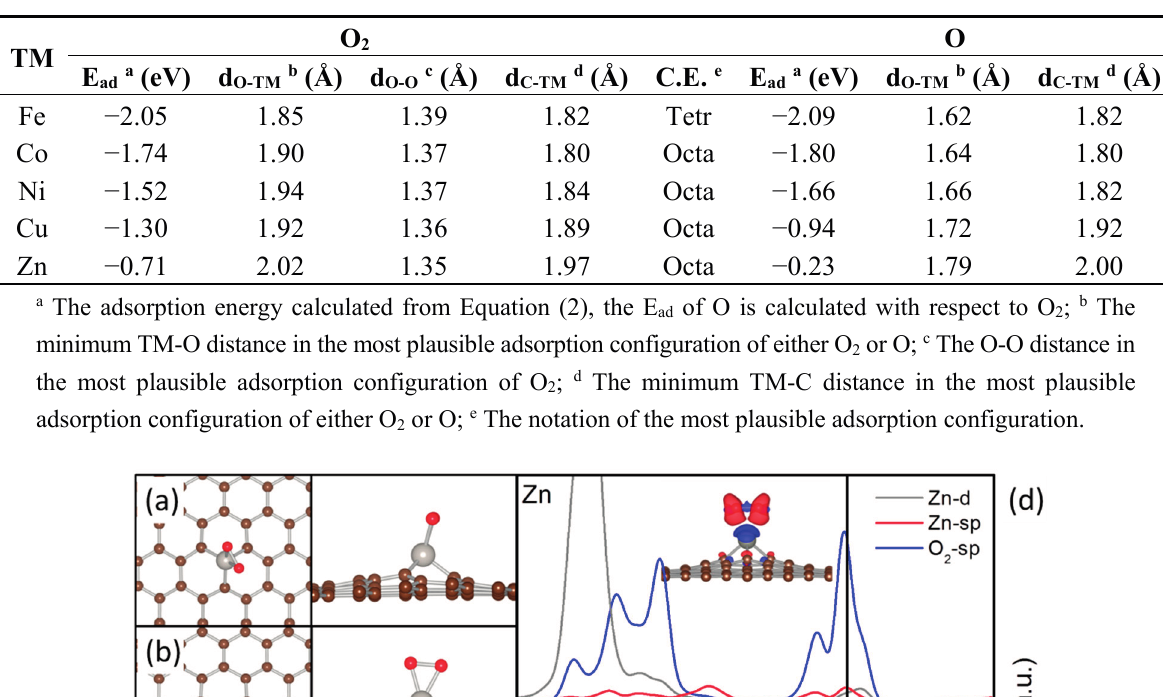
Table 2. The structural and energetic parameters for O 2 and O adsorption on TM-MG composites.